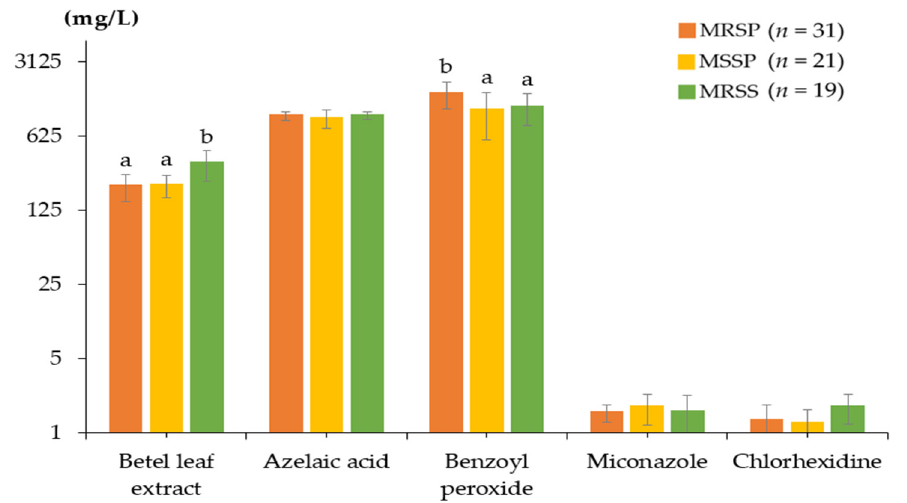
Figure 2. Minimum inhibitory concentrations (MICs) of Piper betle leaf extract, azelaic acid, benzoyl peroxide, miconazole, and chlorhexidine against methicillin-resistant Staphylococcus pseudintermedius (MRSP), methicillin-susceptible Staphylococcus pseudintermedius (MSSP), and methicillin-resistant Staphylococcus schleiferi subsp. coagulans (MRSS). Only chlorhexidine’s MIC was determined in 16 MRSP, 11 MSSP, and 10 MRSS. Data were expressed as means and standard deviations. a, b above mean MIC bars carrying different superscripts is significantly different by Kruskal–Wallis one-way ANOVA ( p < 0.0001).